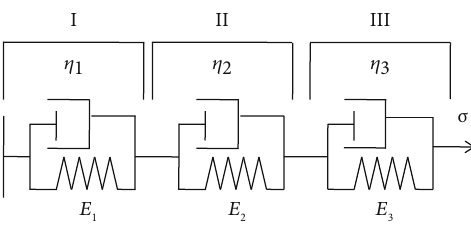
Figure 2: Mechanical model for describing deformation of the material under